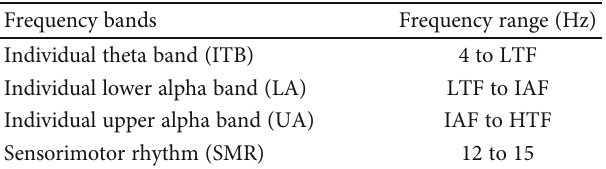
Table 1: Frequency